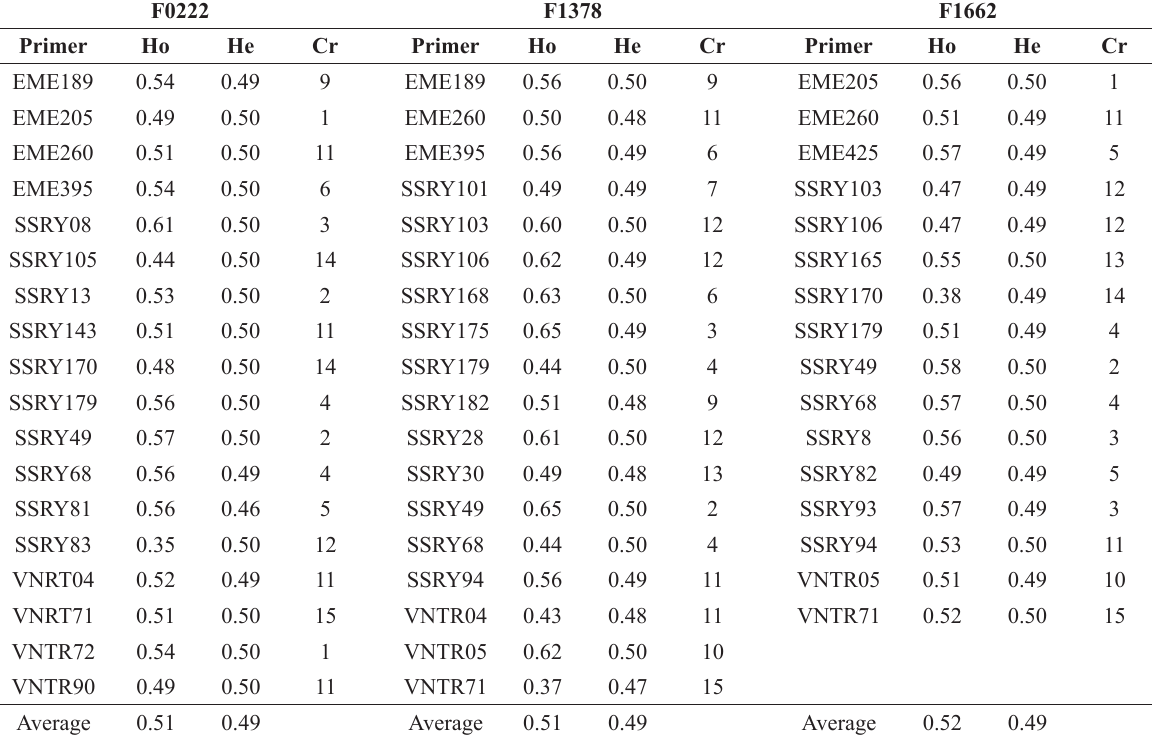
cassava individuals originated from 1